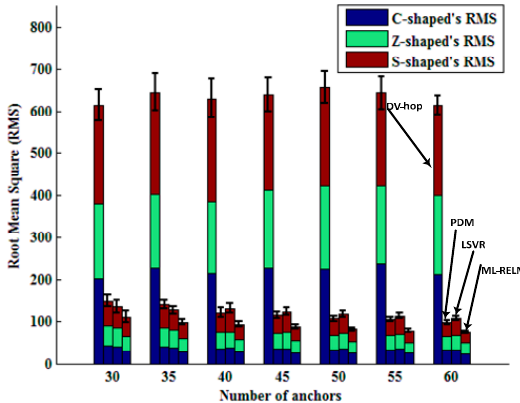
Figure 8. Comparison of different algorithms with different number of anchor nodes in the regular deployment.